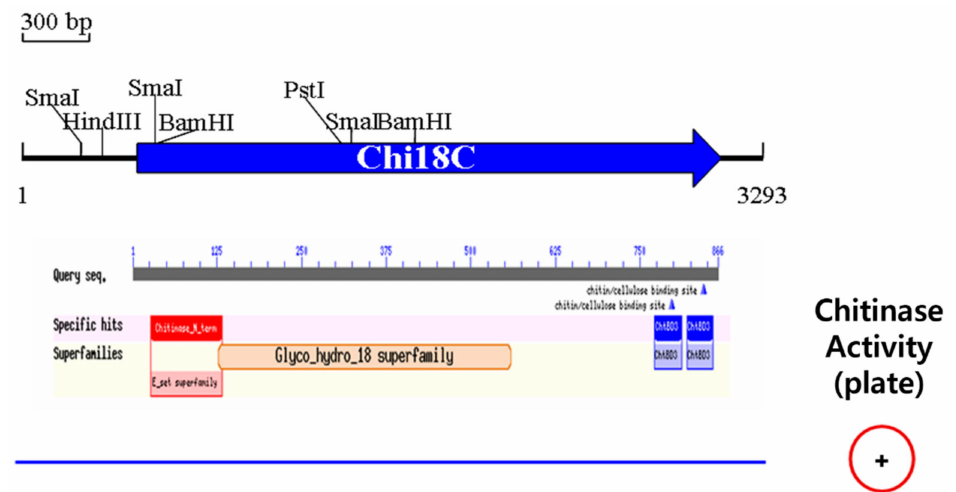
Figure 7. Physical map of the insert DNA of SK15-36. The figure below of the physical map shows the result of BLASTp for Chi18C. The blue line and + symbol at the bottom show DNA of the clone and chitinase activity on the LBCC agar plates, respectively.